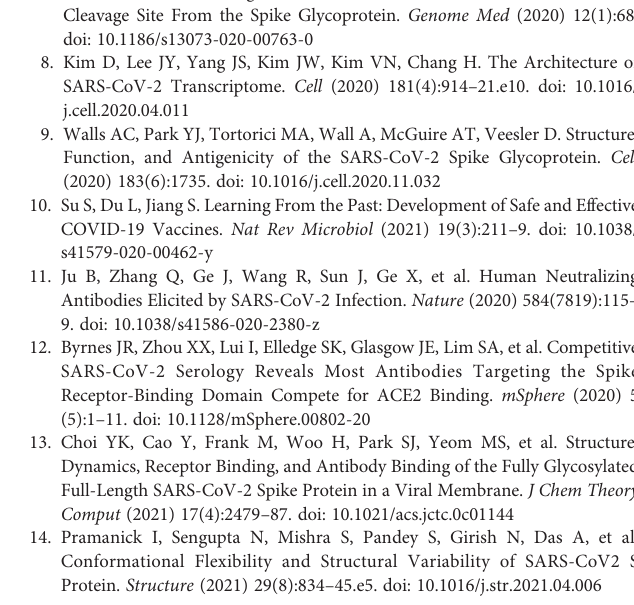
Supplementary Figure S1 | Quanti fi cation of rRBD produced in mammalian system. (A) Increasing volumes of puri fi ed rRBD and known amounts of BSA were resolved on SDS-PAGE. The gel was stained using Krypton fl uorescent protein stain. (B) Lane pro fi ling of total protein signal showing a cross-section view of each lane rotated 90 degrees. Area of green peaks above the lane is proportional to the amount of protein and its value is reported. Rf, current relative front value. Intensity (Int), average intensity value. * indicate the amount of BSA used to build a standard curve; ** indicate the calculated amount of rRBD based on the BSA standard curve. Supplementary Figure S2 | rRBD production in E. coli expression system. (A) Schematic representation of RBD construct in E. coli expression vector. RBD fragment was inserted into BamHI/HindIII restriction sites of pQE30 vector ’ s multi cloning site (MCS), in frame with the ATG and 6xHis tag. (B) Protein purity was analyzed by SDS-PAGE followed by staining with Coomassie blue. Protein identity was con fi rmed by WB using the anti-RGSHHHH antibody. One of three independent experiments is